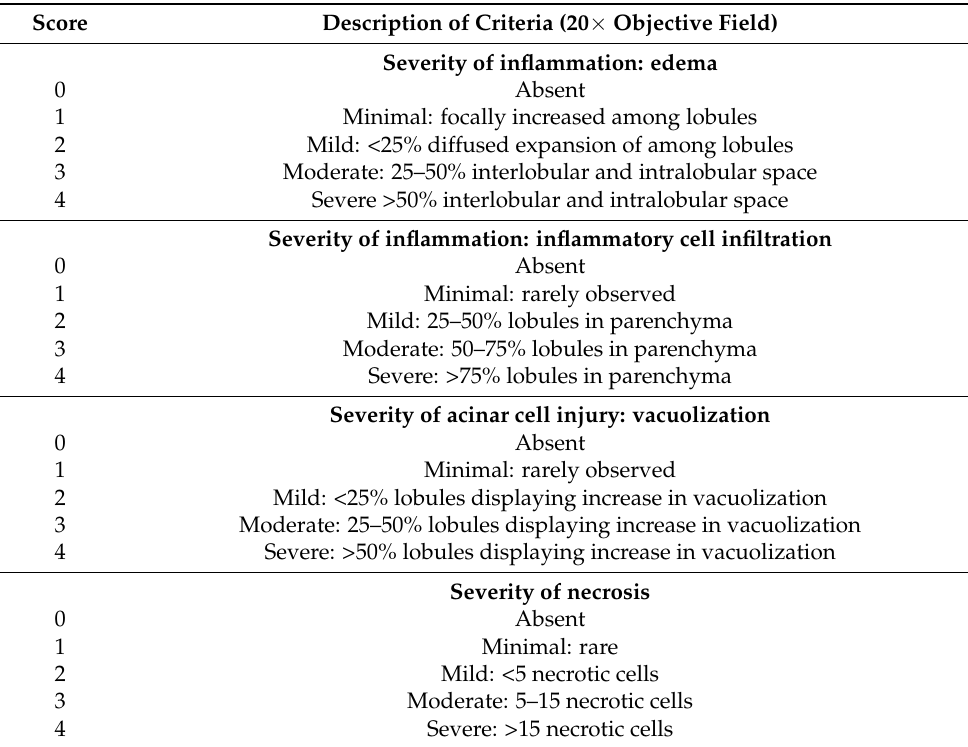
Table 1. Histological scoring system for acute injury phase in mice with cerulein-induced acute pancreatitis (11–24 h after initial injection).